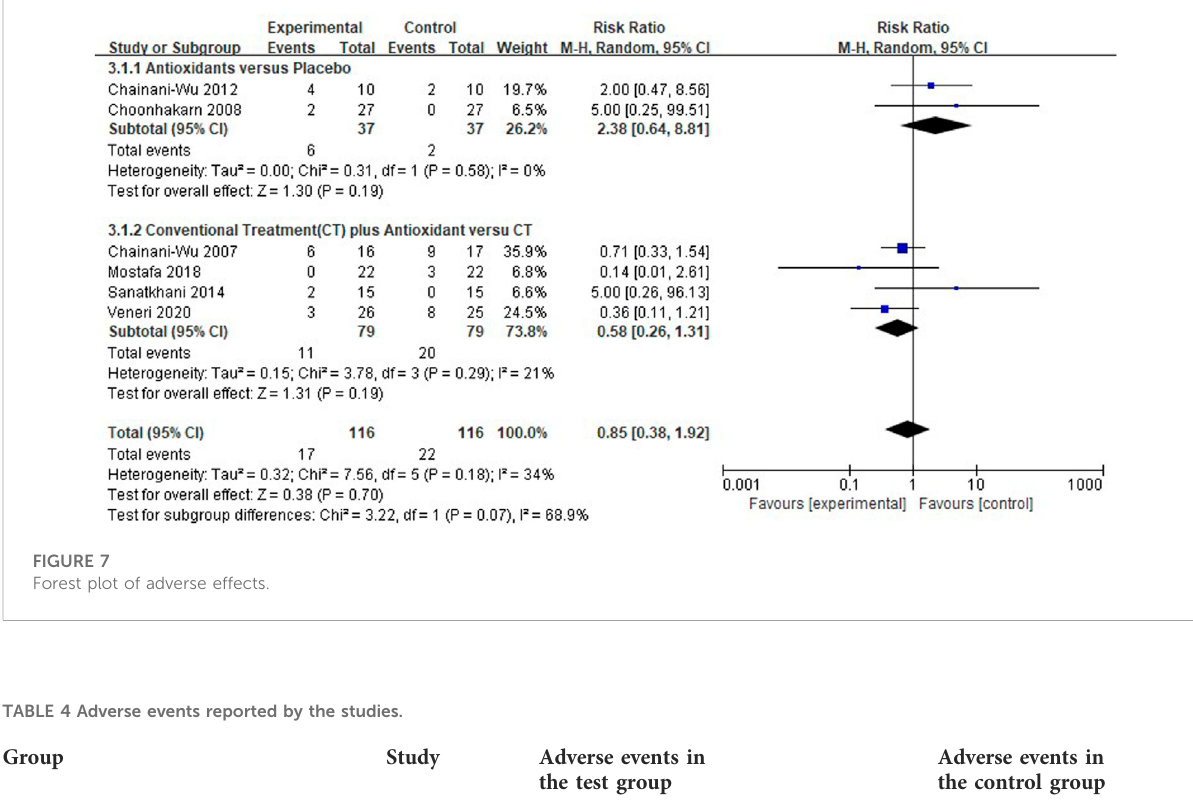
TABLE 4 Adverse events reported by the studies.